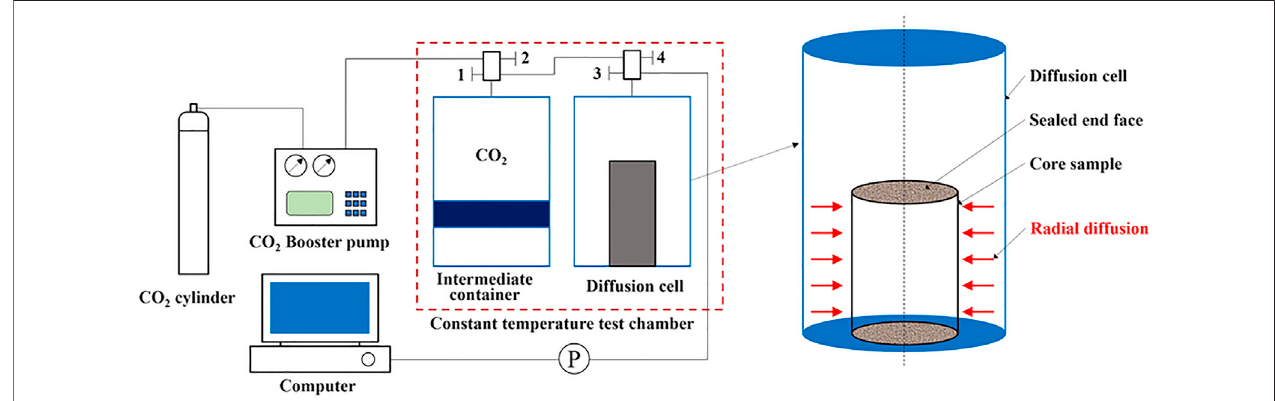
FIGURE 1 | Schematic diagram of experimental apparatus and the physical model for CO 2 diffusion.